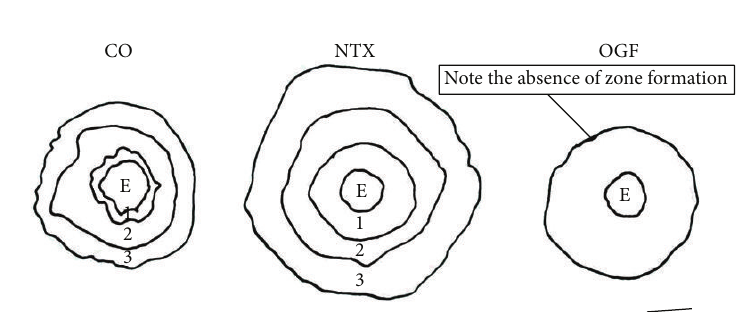
Figure 4: Outgrowths of corneal epithelium from corneal explants in organ culture from camera lucida drawings. CO: control; NTX: naltrexone supplemented culture media; OGF: opioid growth factor supplemented media; E: explant; numbers indicate zones of cellular outgrowth from the explant with zones 1 and 3 having active DNA synthesis and mitotic activity and zone 2 lacking DNA synthesis and mitotic activity. Note: explants exposed to media supplemented with OGF lack defined zone formation (derived from